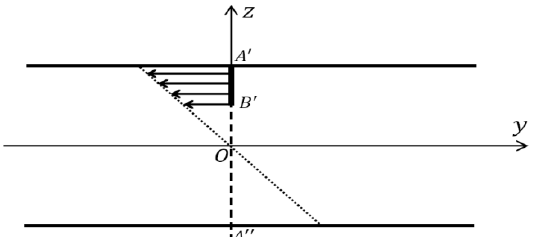
Figure 3: Fictitious source of current equivalent to the zero volume crack between A ’ and B ’ (with B